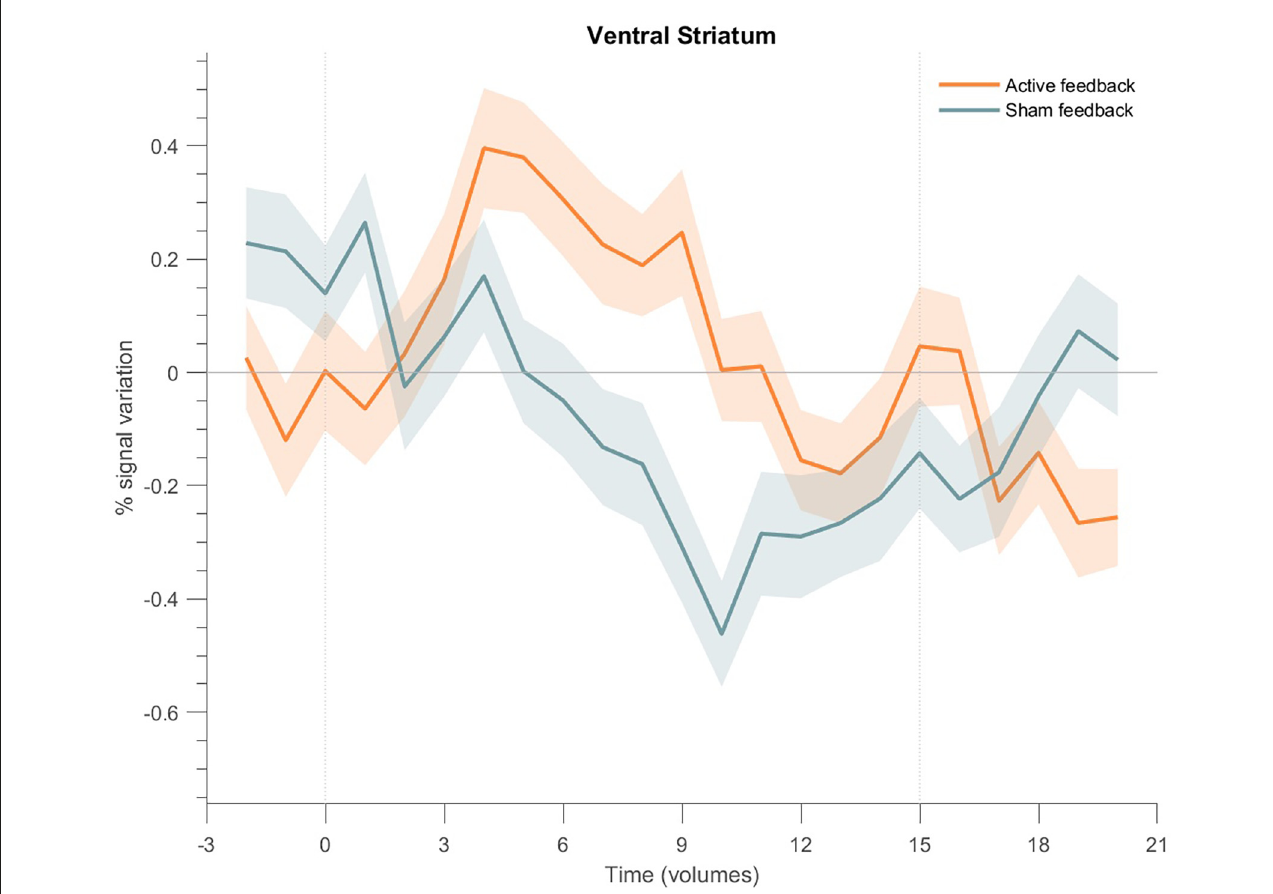
FIGURE9 Event-related fMRI time courses considering the cluster on the ventral striatum for the active neurofeedback group (orange line) and the Sham feedback group (green line); the shaded regions correspond to the standard error of the mean (SEM). The first dotted vertical lines indicate the up-regulation block onset and the second to the end. The time courses show a positive transient response for the active neurofeedback group during the up-regulation condition, particularly at the beginning of each block, followed by the return to baseline activation values; on the opposite, the results show a negative response for the Sham